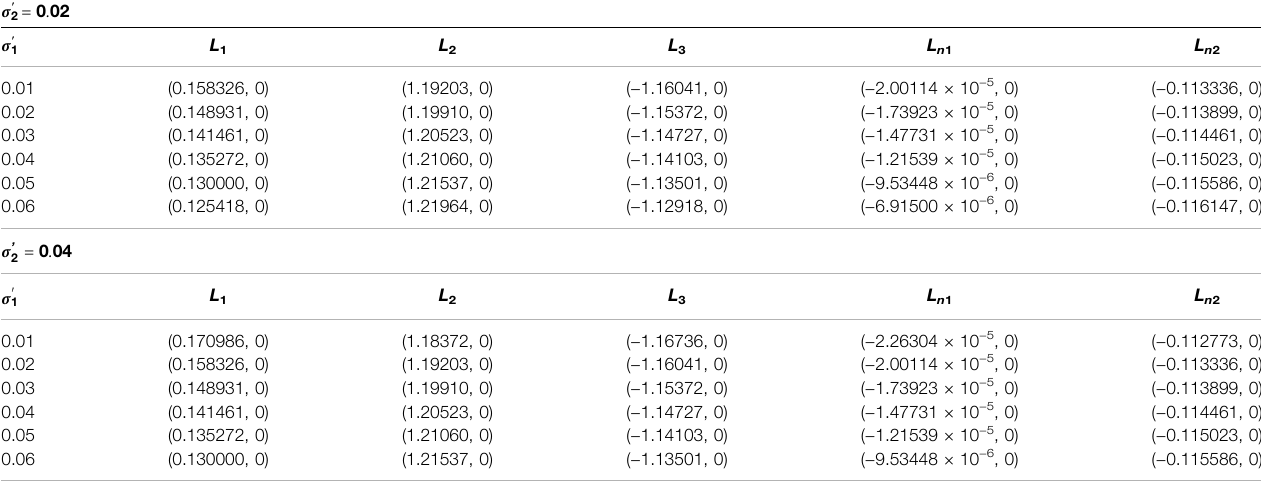
TABLE 10 | Positions ( x 0 , 0) of the collinear points of the binary HD155876 system for fi xed values q 1 = 0.979950, q 2 = 0.983912, A 3 = 0.02, M b = 0.06, T = 0.01, σ 1 = 4 × 10 − 5 , σ 2 = 3 × 10 − 5 , and for two fi xed values of σ 2 ′ when σ 1 ′ varies.